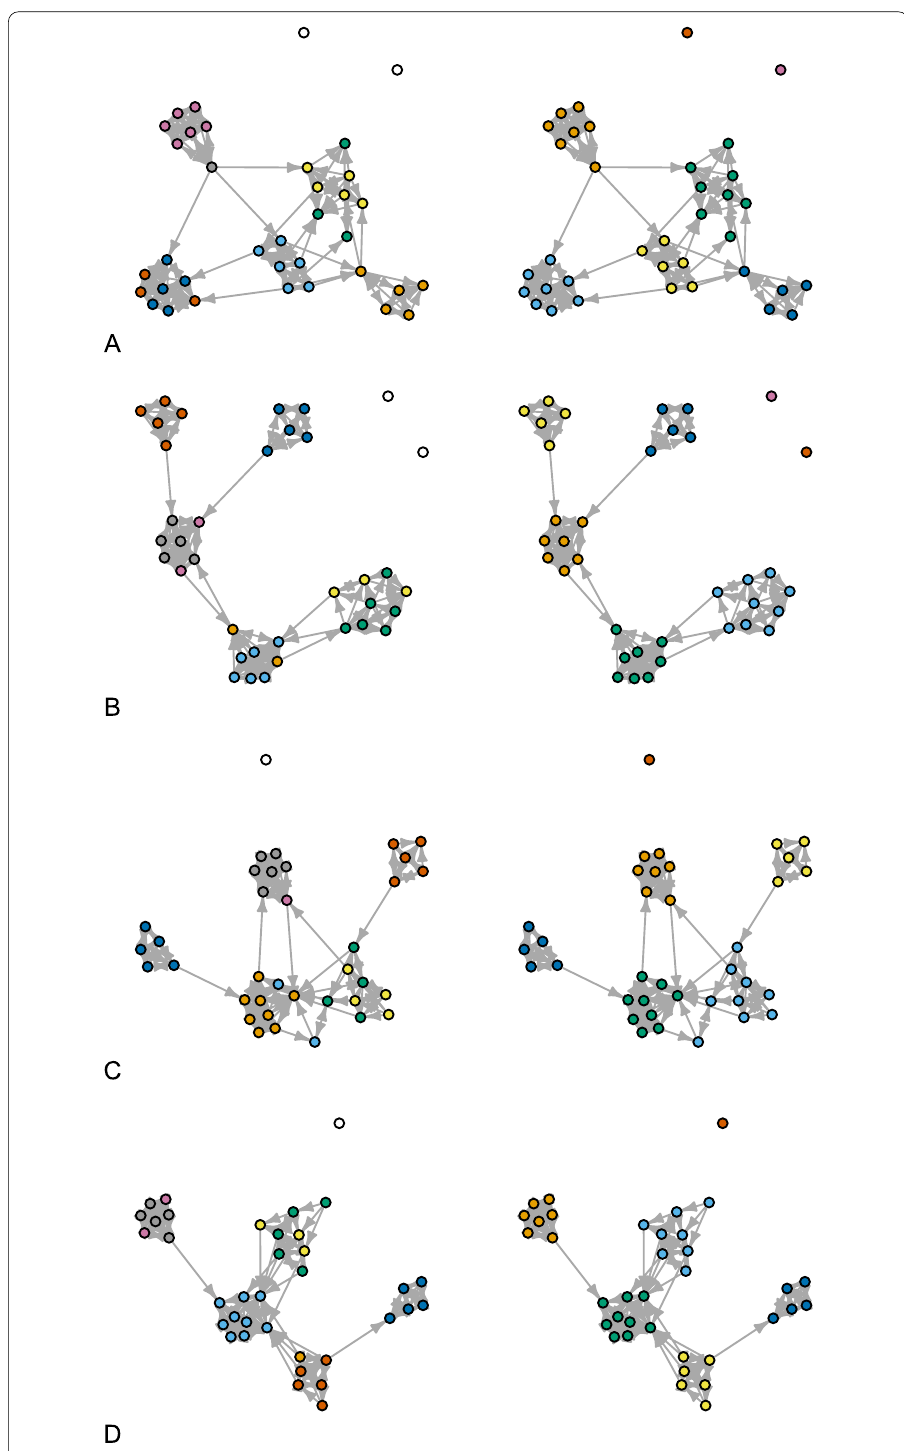
Fig. 20 Spring 2016 sociograms for exams 1–4 in each row labeled A–D respectively. In the left column, node color is given by the CONCOR algorithm, while on the right, node color is given by the edge-betweenness